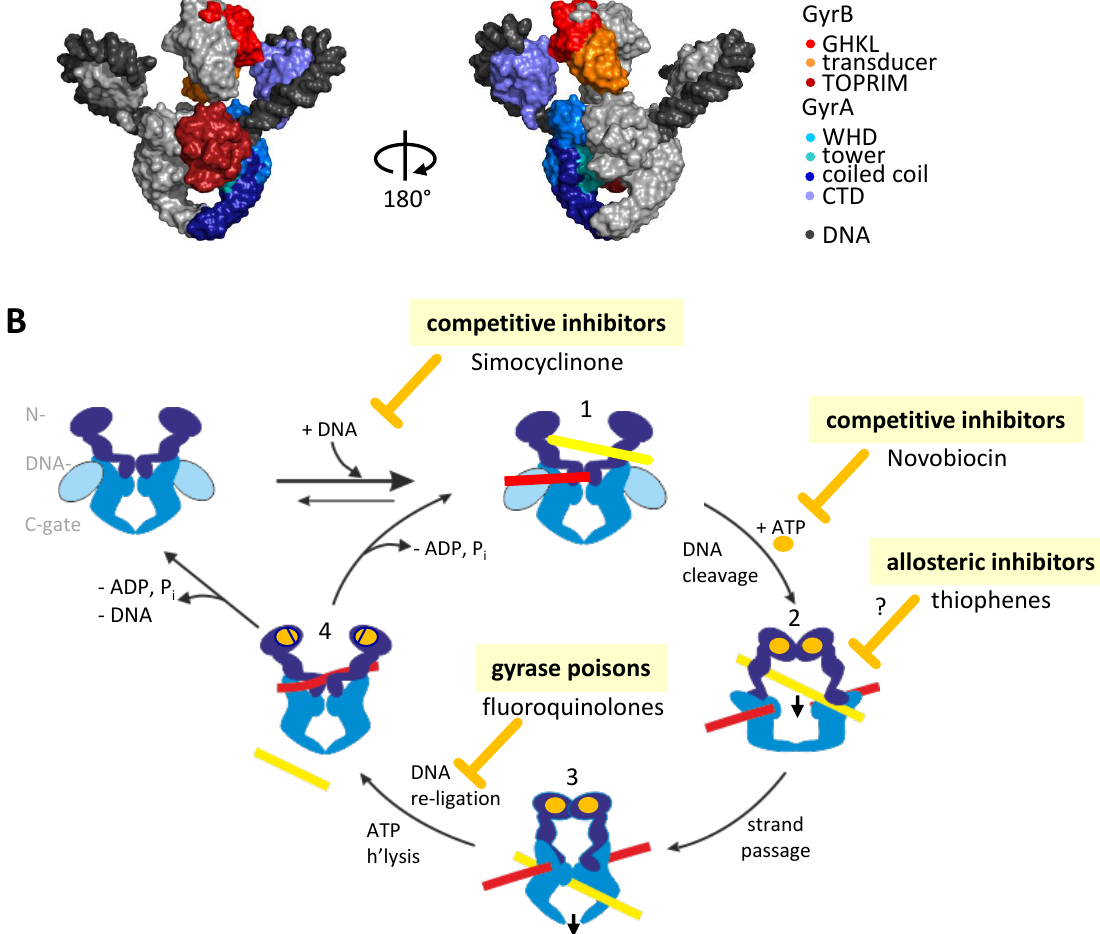
Figure 1. Gyrase function, structure, mechanism, and inhibition. ( A ) Structure of gyrase bound to DNA, the non-hydrolyzable ATP-analog ADPNP, and Ciprofloxacin [16]. One GyrA subunit is colored in blue, one GyrB subunit in red; the second copies are depicted in gray. The DNA (black) binds to the DNA-gate and wraps around both CTDs. GHKL: Gyrase-Hsp90-Histidine Kinase-MutL domain, TOPRIM: topoisomerase–primase domain, WHD: winged-helix domain, CTD: C-terminal domain. Figure from https://www.mdpi.com/1422-0067/19/5/1489, accessed on 3 February 2021. ( B ) Schematic showing the strand-passage mechanism for negative DNA supercoiling by gyrase and steps targeted by inhibitors. Gyrase binds the G-segment (red) at the DNA-gate and a T-segment (yellow) of its DNA substrate (1). Binding of ATP (orange) closes the N-gate and fixes the two segments in a positive node (2). Cleavage of the G-segment at the